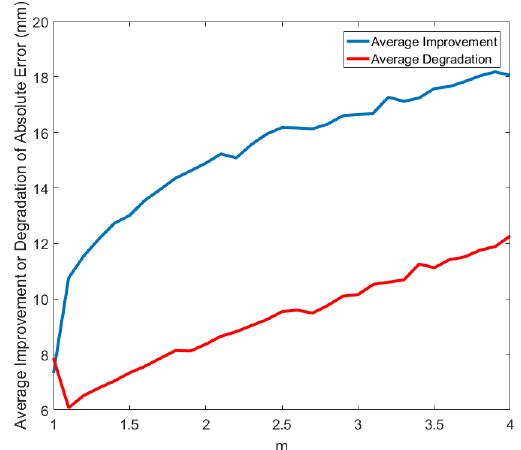
Figure 3. The plot showing average improvement and degradation in absolute error with the proposed method as the value of m changes.